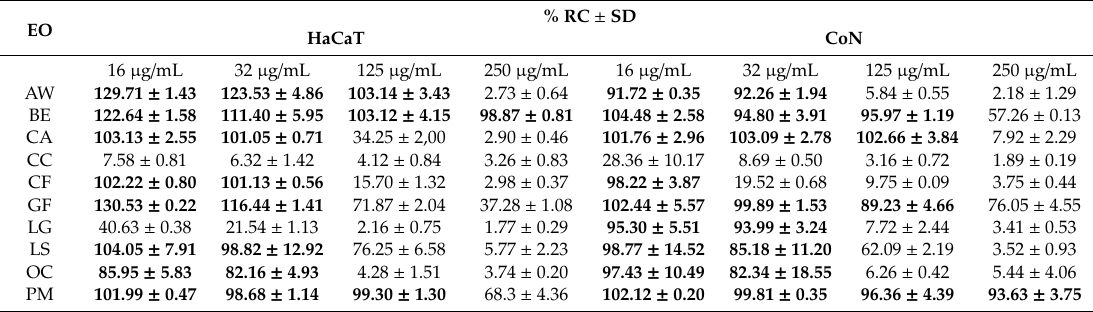
Table 1. Cytotoxicity of the ten essential oils on the keratinocyte cell line, HaCaT (% RC ± SD, n = 3) and on the epithelial cell line, CoN (% RC ± SD, n = 2). In bold, the non-cytotoxic results. % RC ± SD EO HaCaT CoN 16 µ g / mL